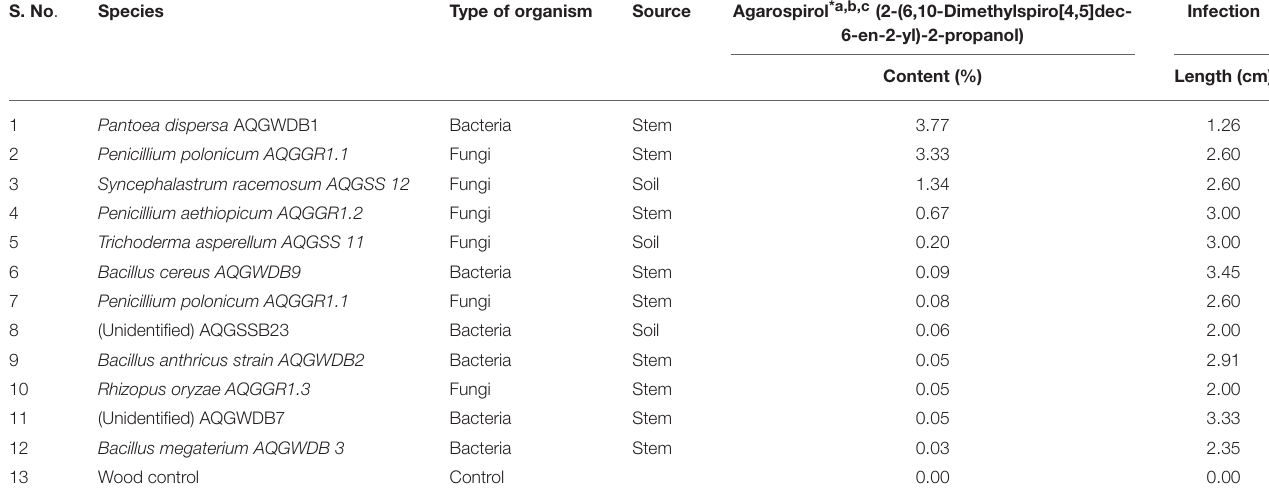
TABLE 3 | Agarospirol content and infection length obtained with different fungal and bacterial strains 3 months after the artificial inoculation in the A. malaccensis trees. S. No